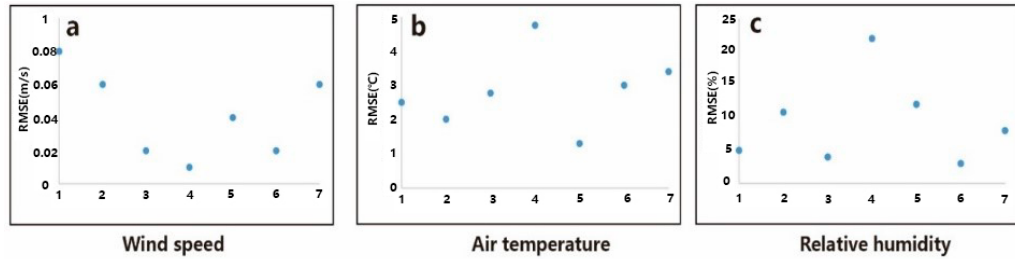
Figure 13. Root-mean-square error (RMSE) between the measured and the simulated data.